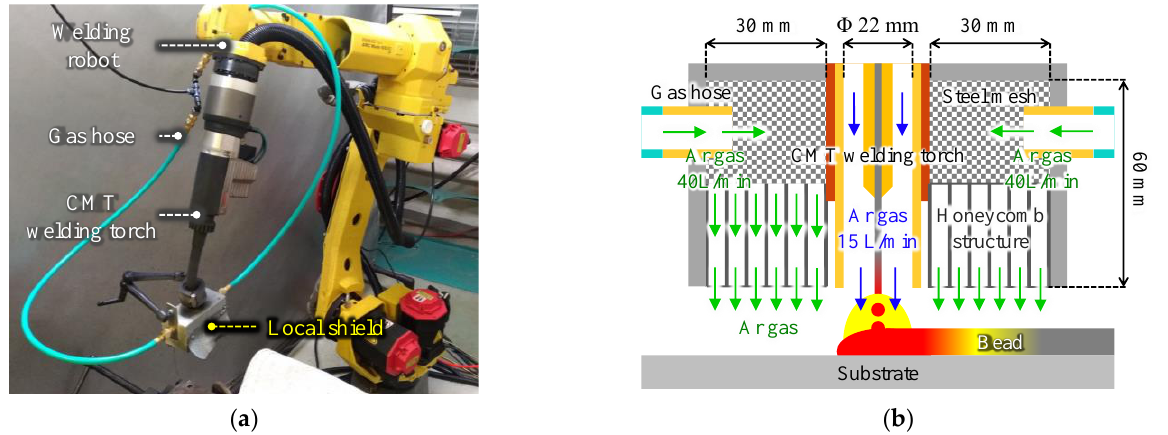
Figure 2. ( a ) Wire and arc additive manufacturing machine and ( b ) internal structure of the local shield.